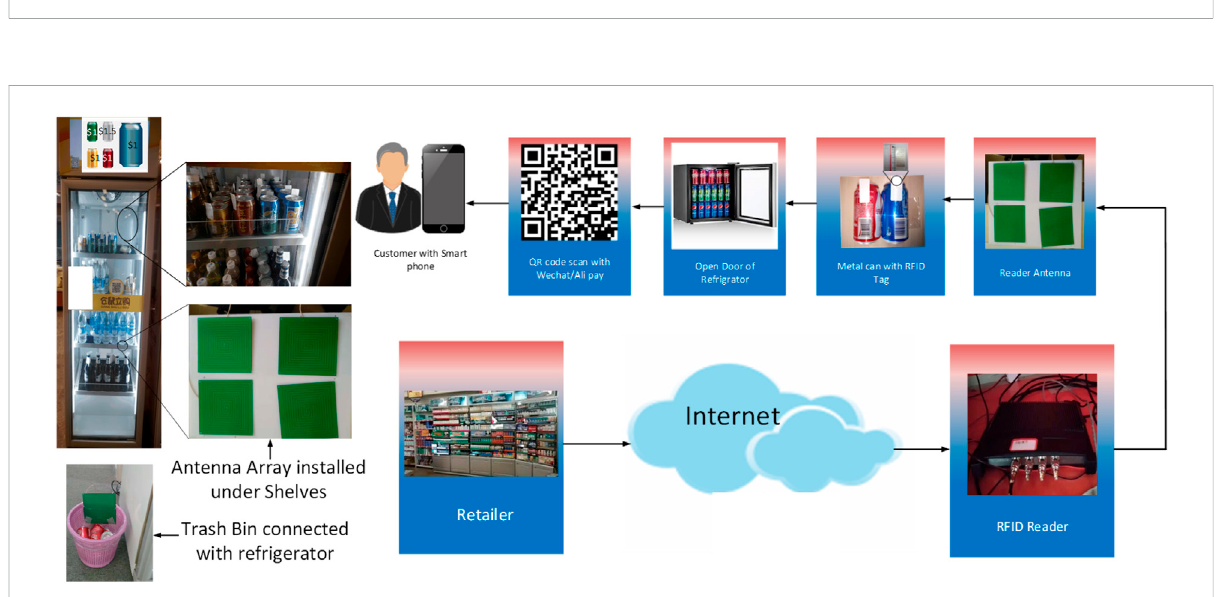
FIGURE 6 Commercial testing setup and block diagram of an RFID-based smart refrigerator (Sharif et al., 2019a).